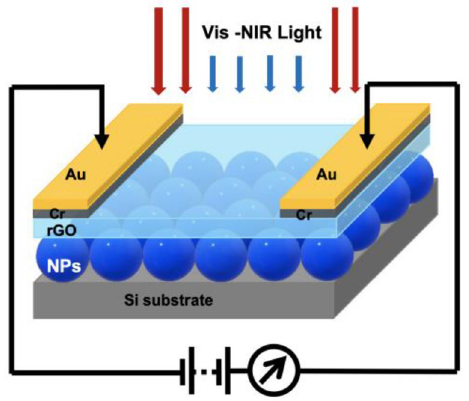
Figure 1. Schematic of plasmonic metallic NPs based on the rGO-Si photodetector.